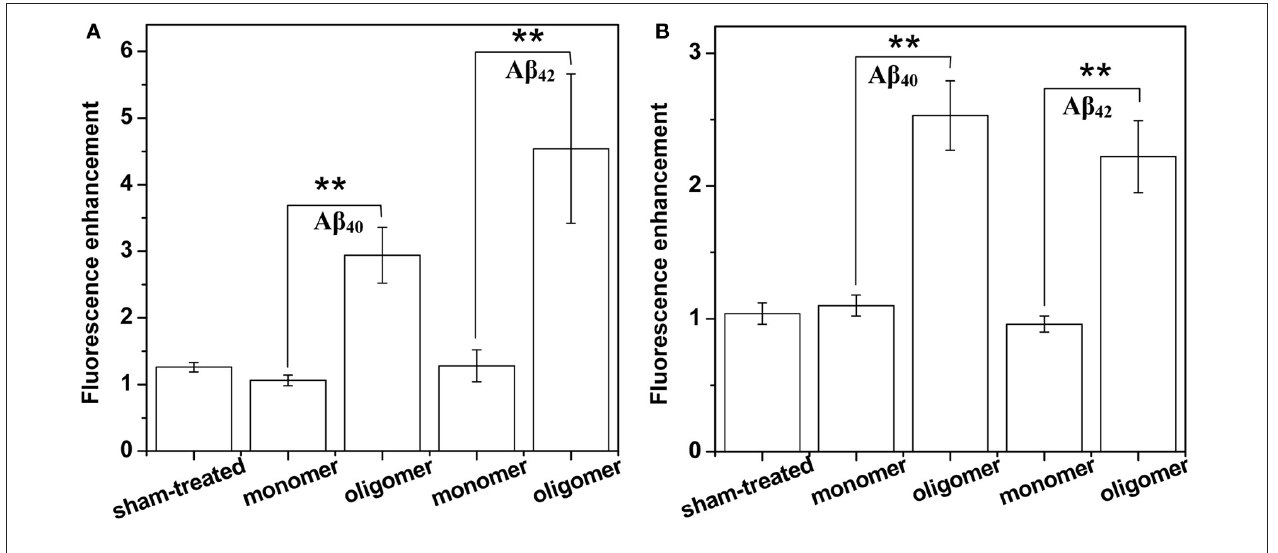
FIGURE 5 | Summary of membrane affinity measurements of A β monomers and oligomers. Increase of membrane brightness of (A) HEK293 cells and (B) RN46A cells after 30min exposure to buffer (first bar), 250nM monomeric and oligomeric RA β 40 (second